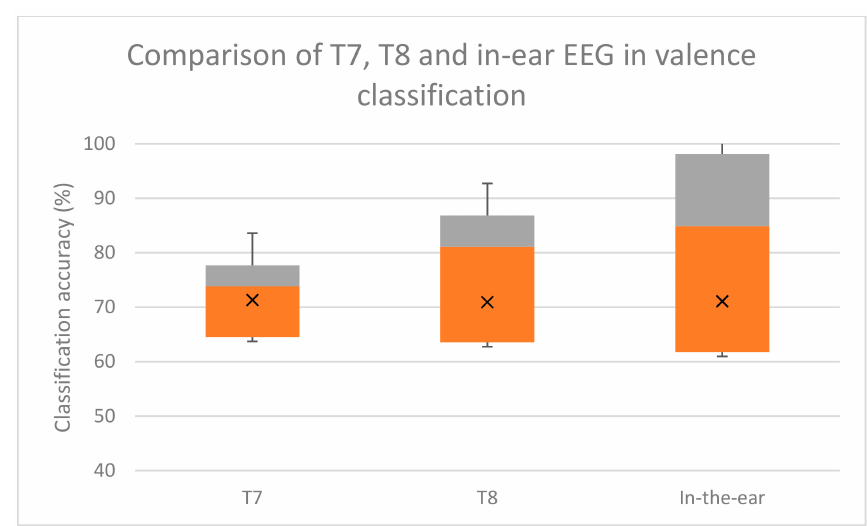
Figure 9. Box plot comparison among valence classifications using single channel T7, T8, and in-ear EEGs. Grey areas indicate proportions of classification accuracy above the median. Orange areas indicate proportion of classification accuracy below the median. X indicates the mean accuracy.